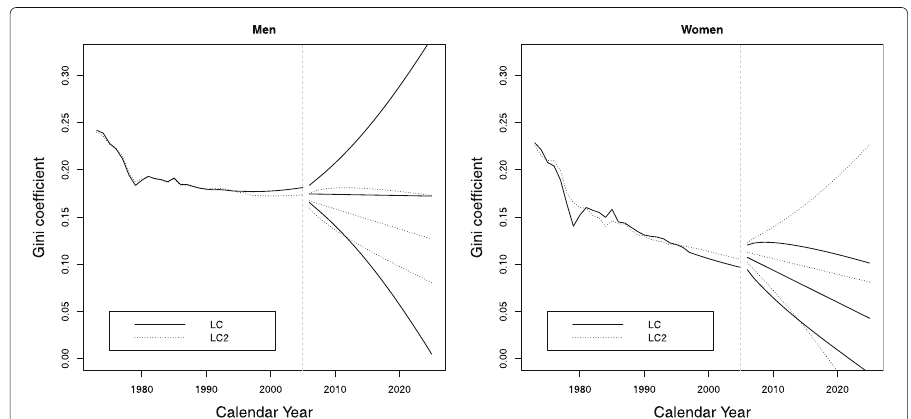
Fig. 14 Evolution of the Gini index between 1973 and 2025, Colombia, men and